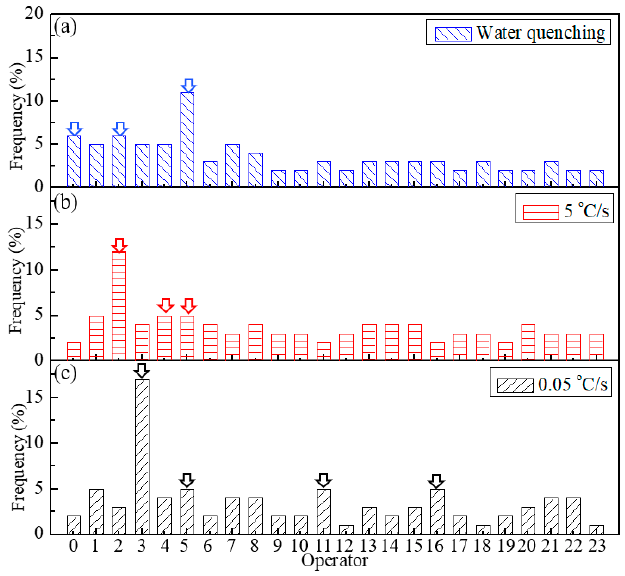
Figure 7. Histogram of operator distribution in three specimens at various cooling rates: ( a ) water- quenching; ( b ) 5 °C/s; ( c ) 0.05 °C/s.